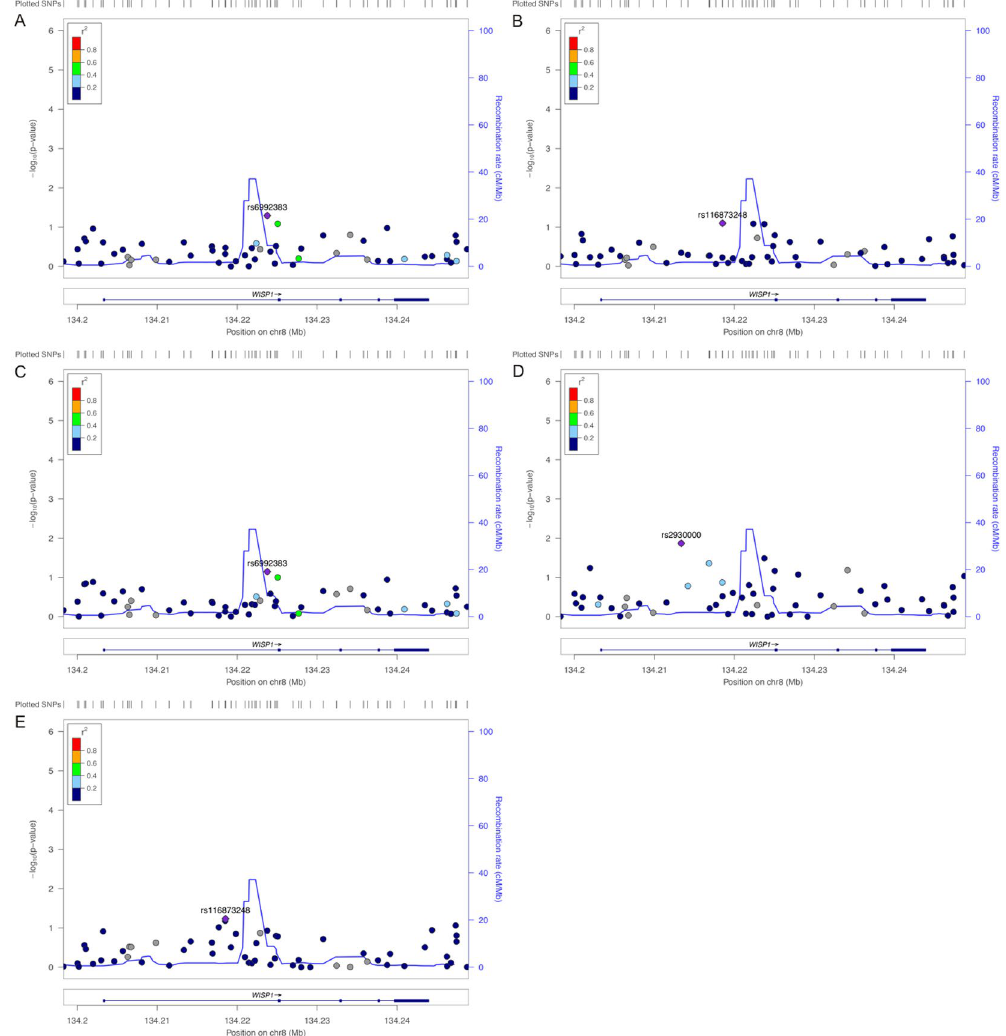
Figure 2. Conditional association plots for the WISP1 ( + / − 5 kb) region for BMD in ( A ) total hip, ( B ) femoral neck, ( C ) hip intertrochanter, ( D ) hip trochanter and ( E ) lumbar spine. Genetic variants within the WISP1 ( + / − 5 kb) are depicted (x axis) along with their association p value ( − log10). The top SNPs, i.e. rs6992383, are denoted by a purple color. Variants are color coded according to their LD (r 2 ) with the lead SNP (1000 Genomes Project Nov 2014 EUR population). The recombination rate (grey line) and position of gene, its exons and direction of transcription are also